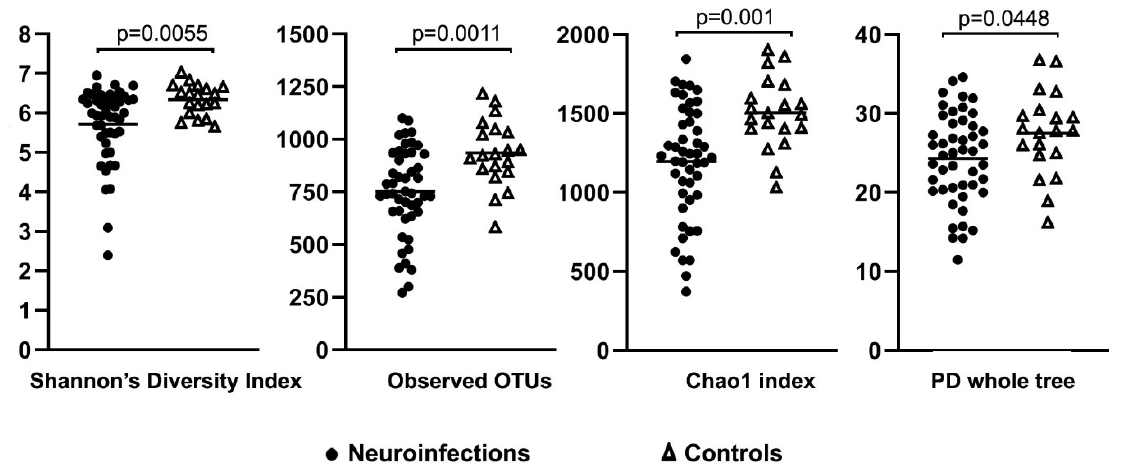
Figure 2. Various alpha diversity metrics in 47 patients with neuroinfection and 20 controls. Beta diversity, defined by principal coordinate plots (PCoA) and the analysis of similarities (ANOSIM), did not differ significantly between patients with neuroinfection and controls. Similarly, there were no differences when bacterial and viral cases were compared to each other and to controls (Figure 3).